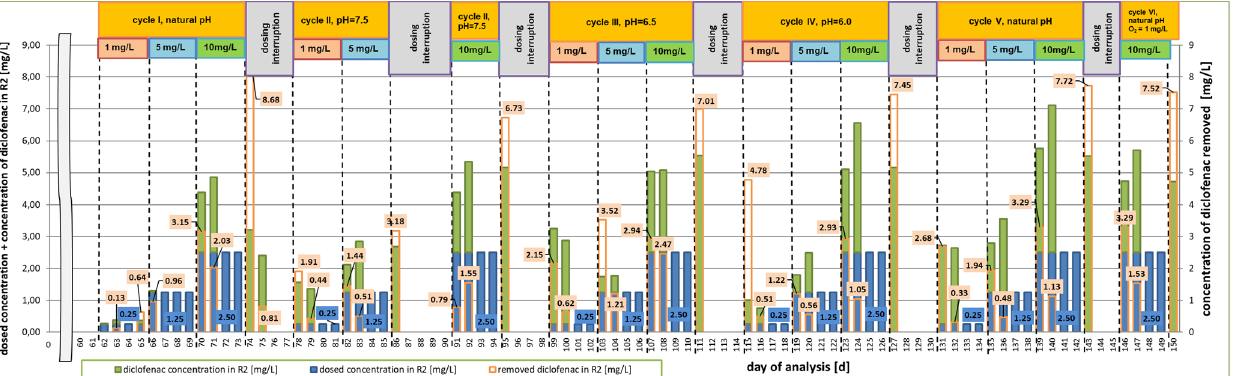
Figure 4. Concentration of the removed diclofenac in relation to dosing the dose of the drug along with its residue in the R2 reactor.